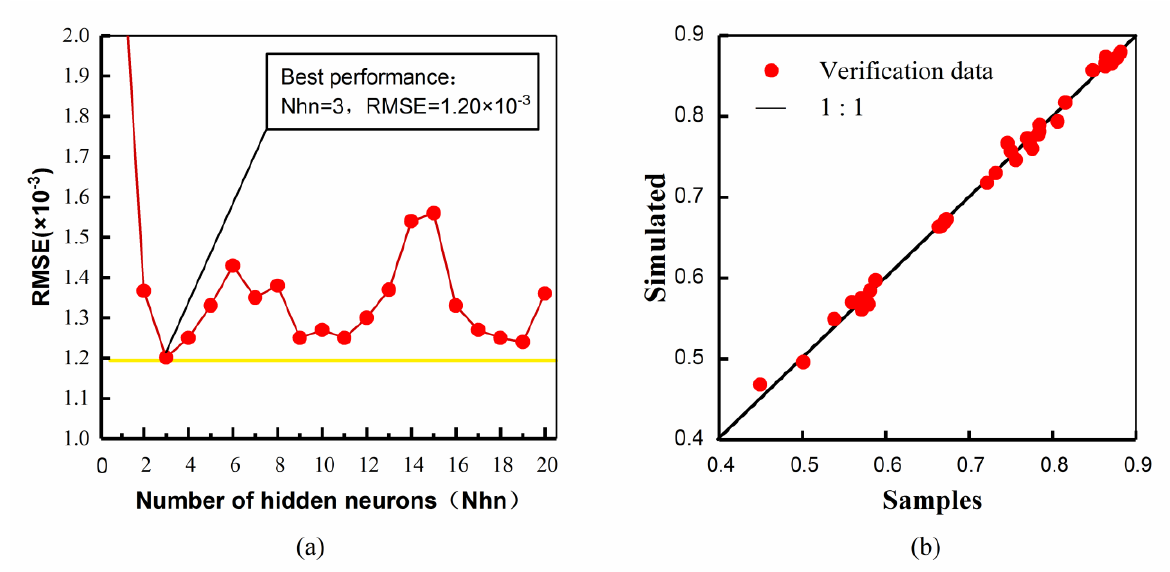
Figure 7. Results of training ISM-RWTS for May: ( a ) the performance of hidden neuron number, ( b ) the test of learning ability.